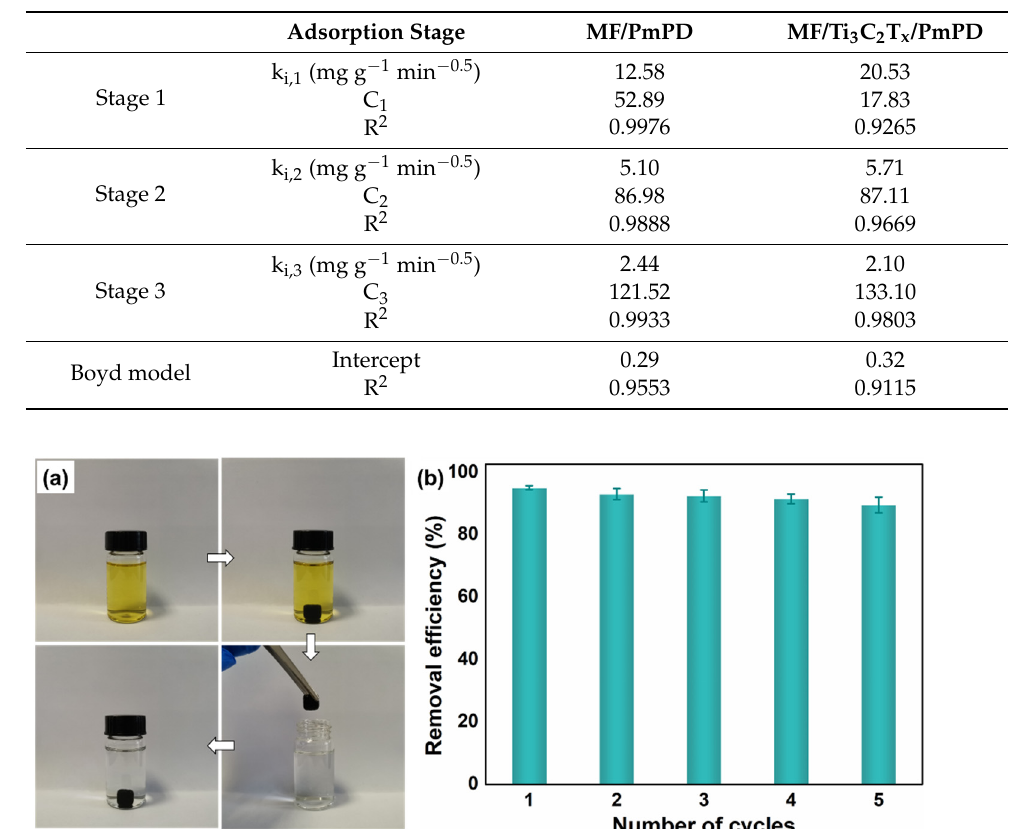
Table 4. The fitted parameters of intraparticle diffusion model and Boyd model of Cr(VI) adsorption by MF/PmPD and MF/Ti 3 C 2 T x /PmPD.